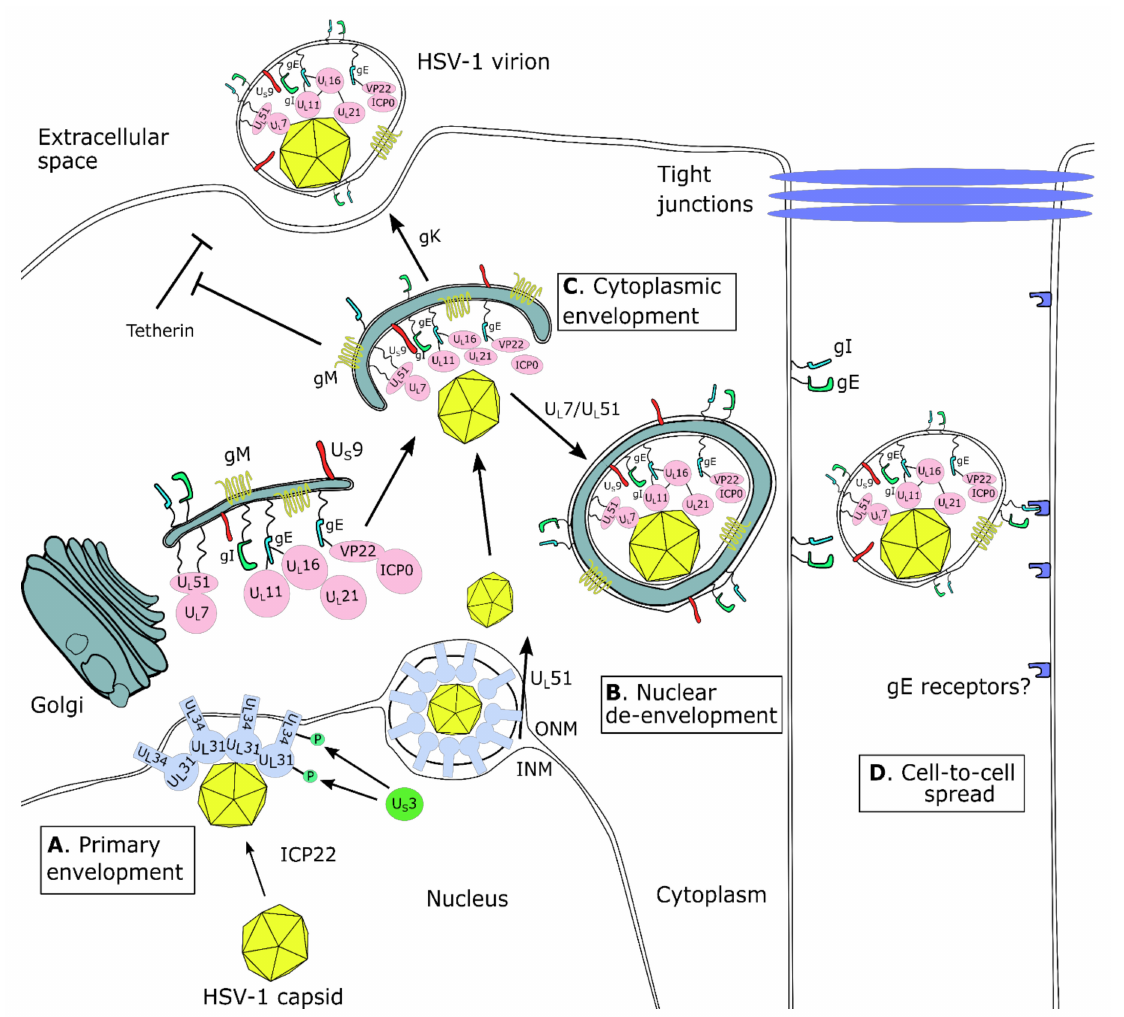
Figure 3. HSV-1 egress and relevant non-essential proteins. Essential proteins are not depicted. ( A ) U L 31 and U L 34 form the Nuclear Egress Complex (NEC), which drives the vesiculation of the inner nuclear membrane (INM) and primary envelopment of HSV-1 capsids. ( B ) Nuclear de-envelopment is mediated by U L 51. Tegument and envelope proteins assemble in a complex network on membranes derived from the trans-Golgi network. ( C ) HSV-1 capsids undergo cytoplasmic envelopment in a process regulated by multiple non-essential proteins, which involves functional redundancy. After cytoplasmic envelopment, enveloped virions are sorted to the extracellular space, which requires gK. HSV-1 release from the cell membrane can be inhibited by tetherin, which is counteracted by gM. ( D ) Depending on cell type (e.g., polarized epithelial cells), enveloped virions can disseminate through cell-to-cell spread, in a process that requires U L 7/U L 51 for sorting of virions towards parts of the membrane that contain gE/gI. Virions may spread to adjacent cells by binding to gE/gI receptors in adjacent cells. However, such receptors are